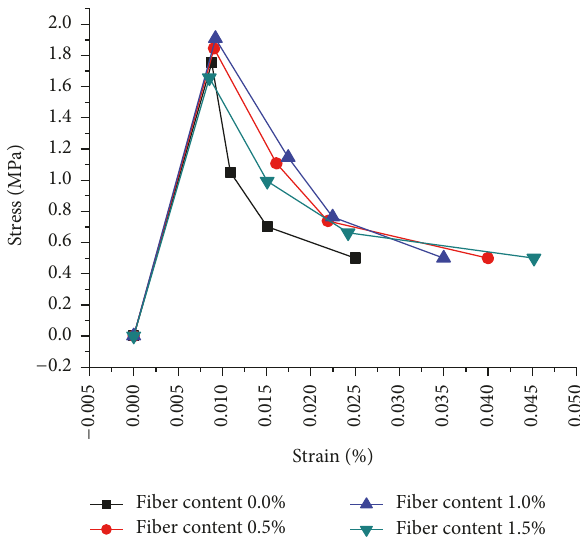
Figure 5: Axial tensile stress-strain full curve.